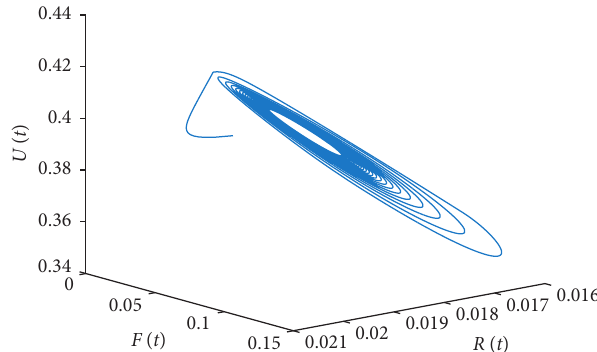
Figure 13: Portrait diagram of land model (30) with ϕ � 0 . 90, � 728 . 403. τ � 740 > τ 0